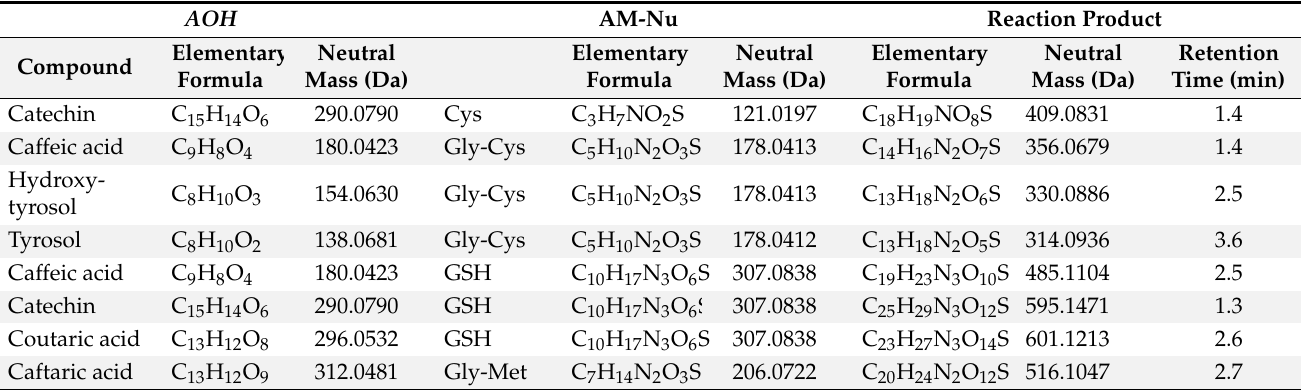
Table 1. Extract of Table S4 presenting the summary of reactions between targeted phenolic